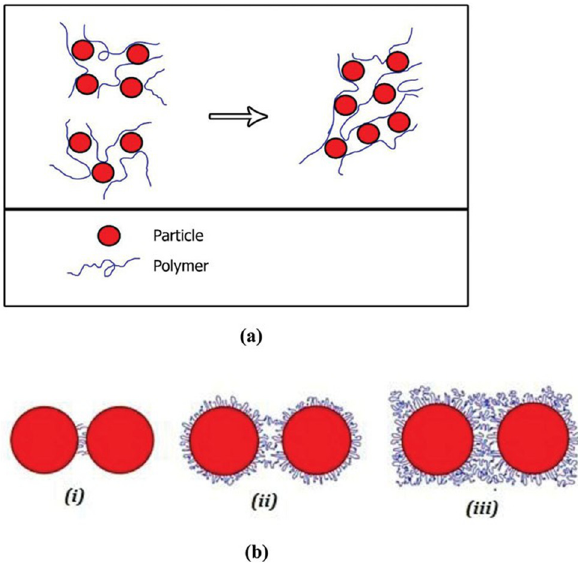
Figure 4: ( a ) Mechanism of irreversible bridging of silica particles through adsorption of PAM on silica surface. ( b ) E ff ect of polymer concentration on degree of bridging of silica particle in silica/PAM suspension [ 120 ]